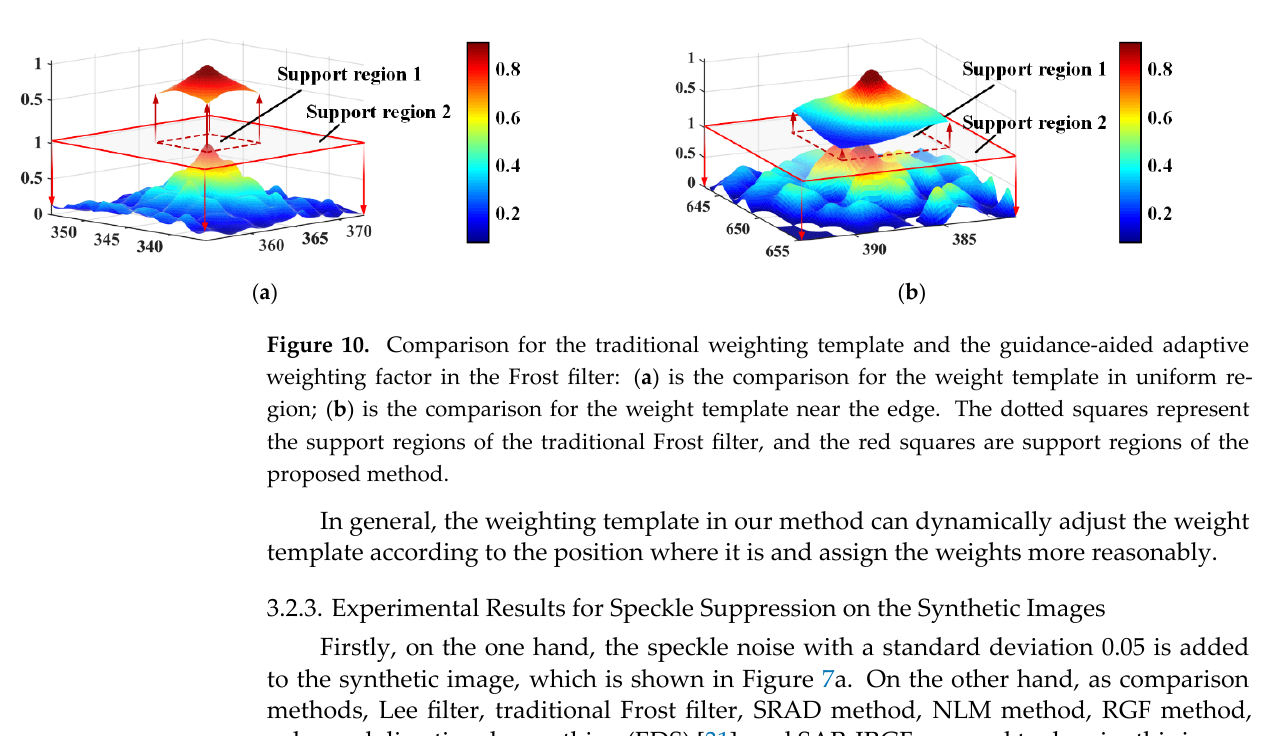
the bottom. The squares boxed in a red line represent the scale-adaptive support regions,